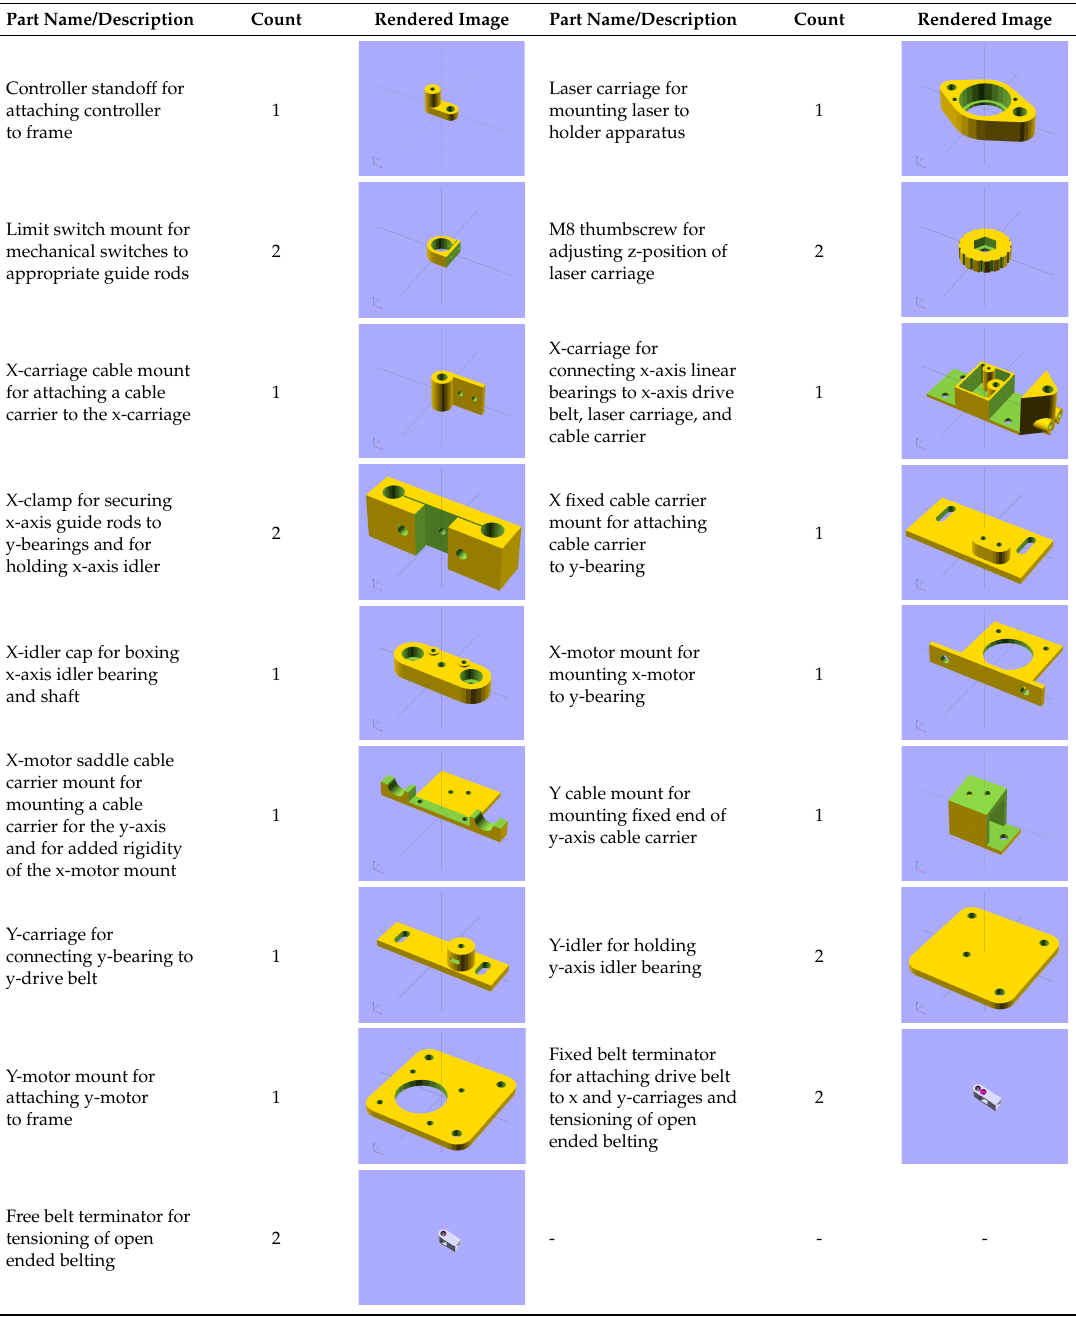
Table 1. Three-dimensional (3-D) printed parts.